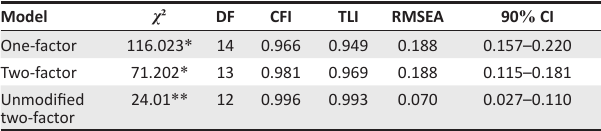
TABLE 2: Goodness-of-fit indices of models for the generalised anxiety disorder-7 scale ( N = 208).